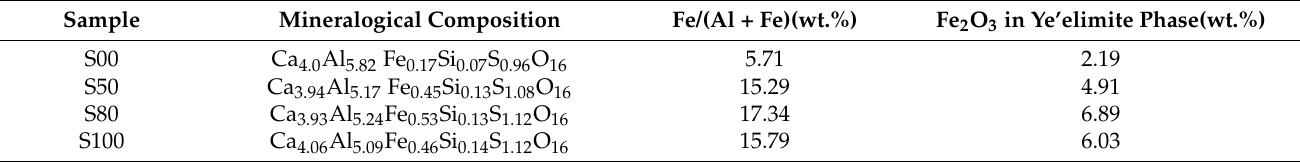
Table 4. Mineralogical composition of ye’elimite phase of samples S00, S50, S80 and S100. Sample